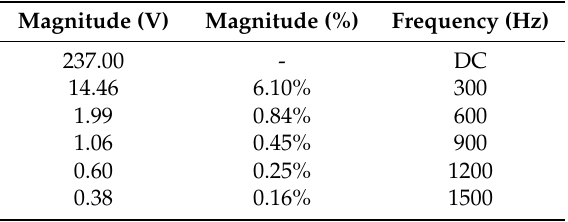
Table 2. Spectral analysis of the ripple content of the signal in Figure 6a.